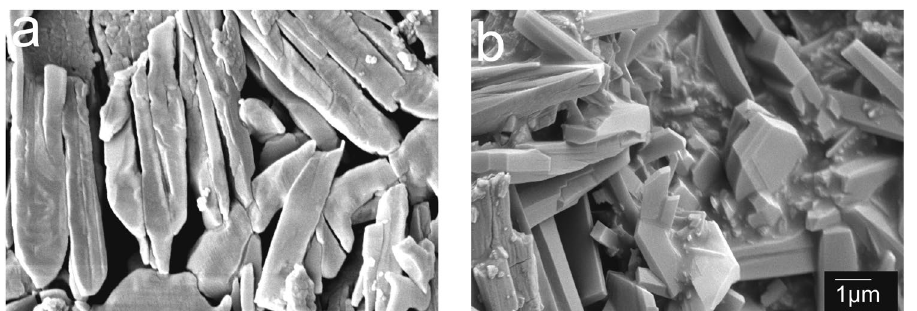
Figure 2. The scanning electron microscopy (SEM) of Sr-based MOFs before and after loading ketoprofen: ( a ) Sr/PTA-MOF, ( b )